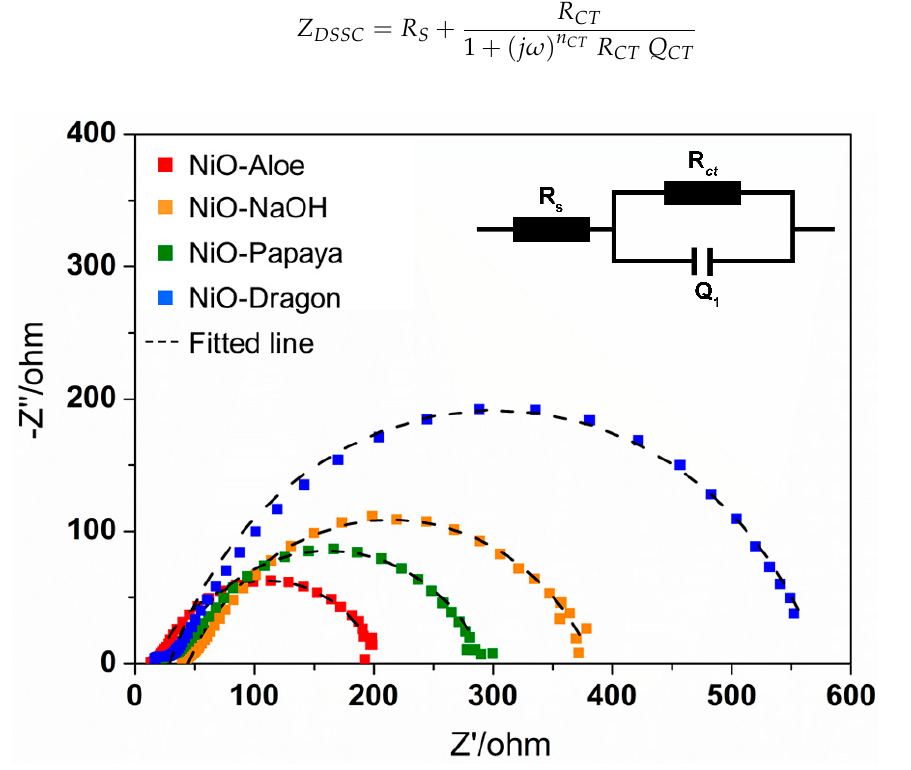
Figure 8. Nyquist plots from EIS analysis.